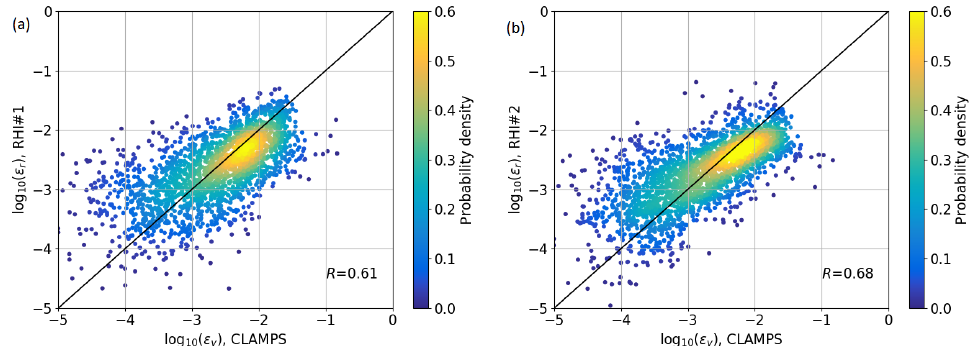
Figure 8. Comparison of all estimates of ε in the vertical profile over the valley from 9 to 15 June 2017 from RHI#1 (a) and RHI#2 (b) against the Halo Photonics system. The color scale represent the density of probability of a measurement point. The black line shows the identity line.